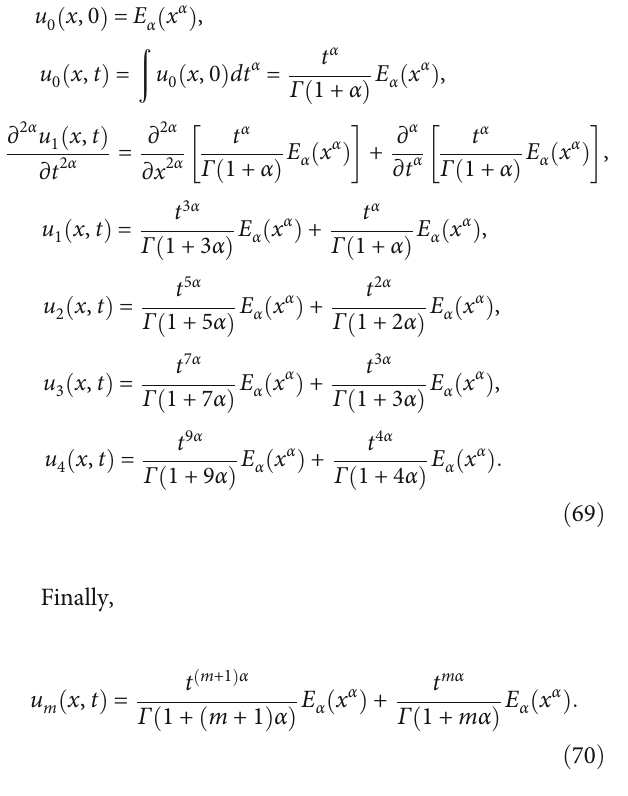
Figure 8: Variation of u ð x , t Þ versus x with α = 1 , t = 0 : 6 sec